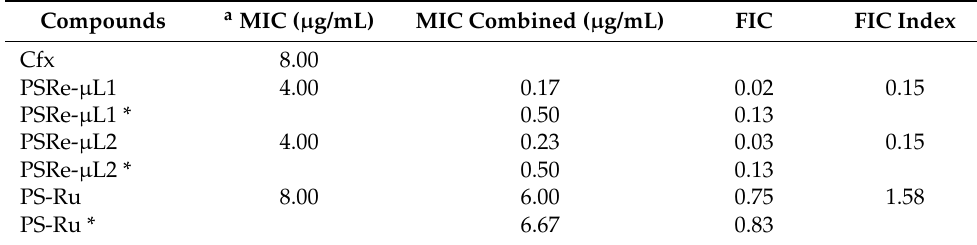
Figure 6. Determination of FIC index using combined photodynamic inactivation and cefotaxime antibiotic. A population of 66 ESBL-producing clinical isolates of K. pneumoniae was used to determine the modification on Cfx-MIC by the PSs and the modification in PSs-MECs by cefotaxime. To determine the Cfx-MIC modification, 1 × 10 7 CFU/mL of bacteria were mixed in triplicate with 4 µ g/mL of PSRe-µL1, PSRe-µL2, or PS-Ru. The mix was added to serial dilutions of Cfx and incubated for 1 h with 17 µ W/cm 2 of white light or in the dark. The Cfx-MIC was then determined after 16–20 h at 37 °C in the dark ( A ). The MEC for PSRe-µL1 and PSRe-µL2 were determined in combination with 4 µg/mL of Cfx, performed in triplicate in ca-MH agar for 16–20 h ( B ). The MIC values are presented as median ± SD of µ g/mL on a log 2 scale. Not significant (ns) p > 0.05 by Student’s t -test among treated bacteria compared to control; * p < 0.05, ** p < 0.01, *** p < 0.001 by Student’s t -test among treated bacteria compared to control. Table 2. FIC index calculation.